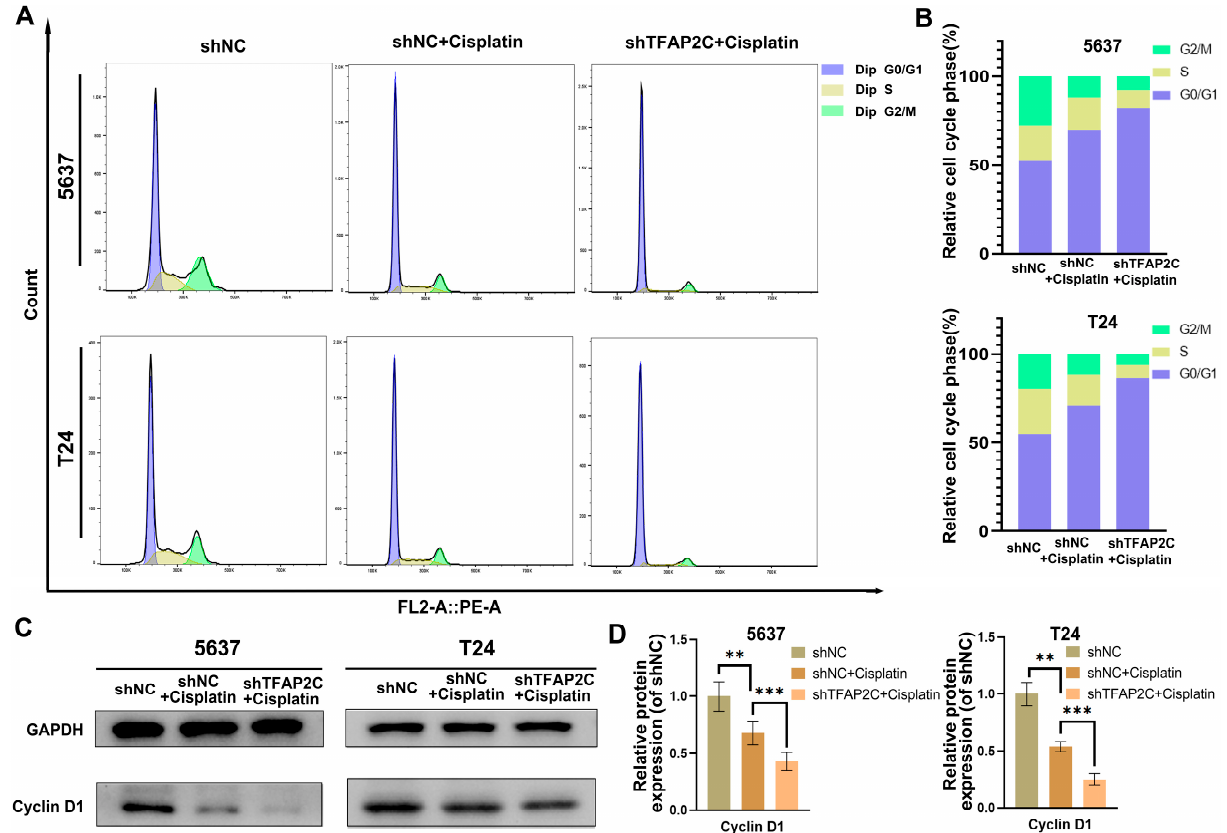
Figure 5. TFAP2C knockdown enhances cisplatin-induced cycle arrest. ( A , B ) Flow cytometry results of the cell cycle in T24 and 5637 cells. ( C , D ) Protein expression levels of cyclin D1. Data represent the mean ± standard deviation (SD) of three independent experiments (** p < 0.01, *** p < 0.001, ns, not significant).